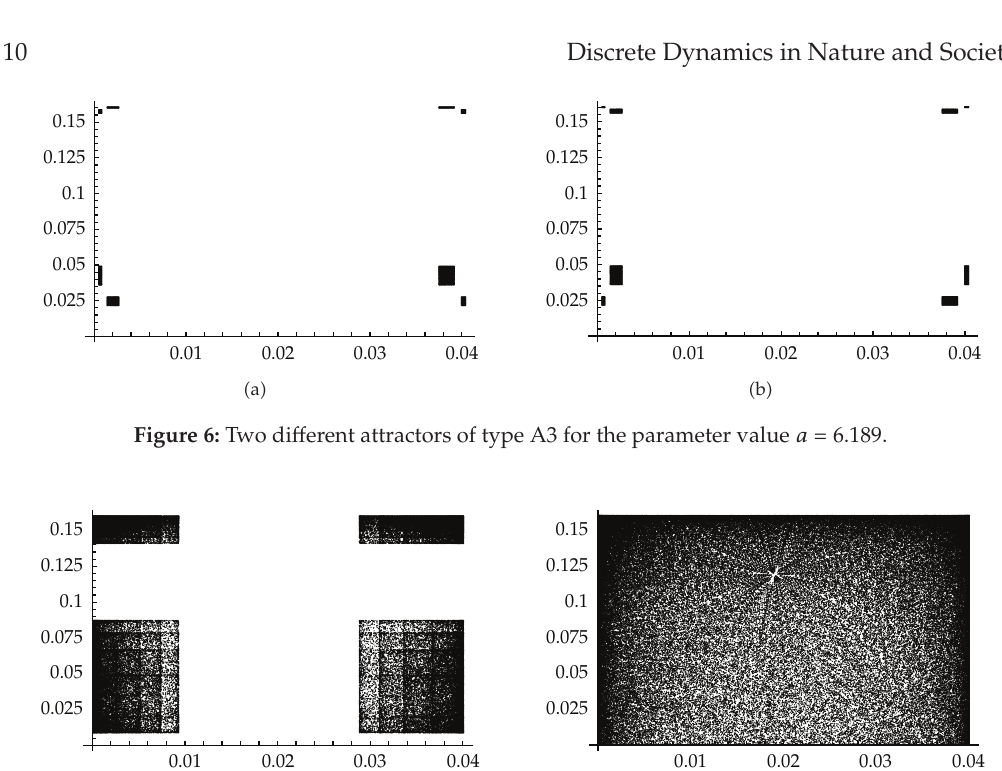
points in the set { (cid:4) x, f 2 (cid:4) x (cid:5)(cid:5) : x ≥ 0 }∪{ (cid:4) f 1 (cid:4) x (cid:5) , x (cid:5) : x ≥ 0 } . In general, the ω -limit sets for